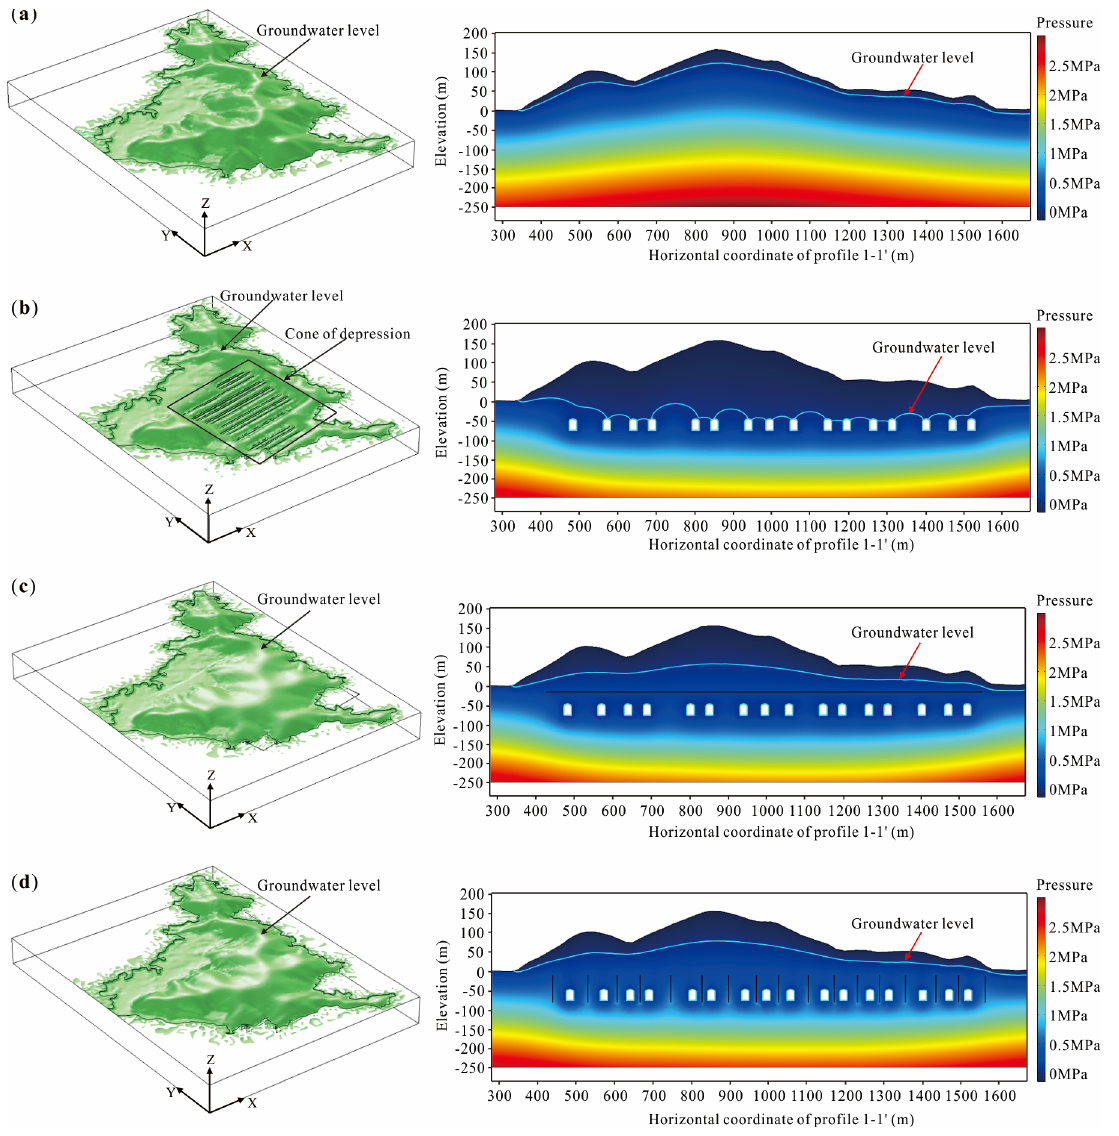
Figure 11. Groundwater level: ( a ) un-excavated; ( b ) excavated; ( c ) horizontal water curtain system; ( d ) vertical water curtain system.